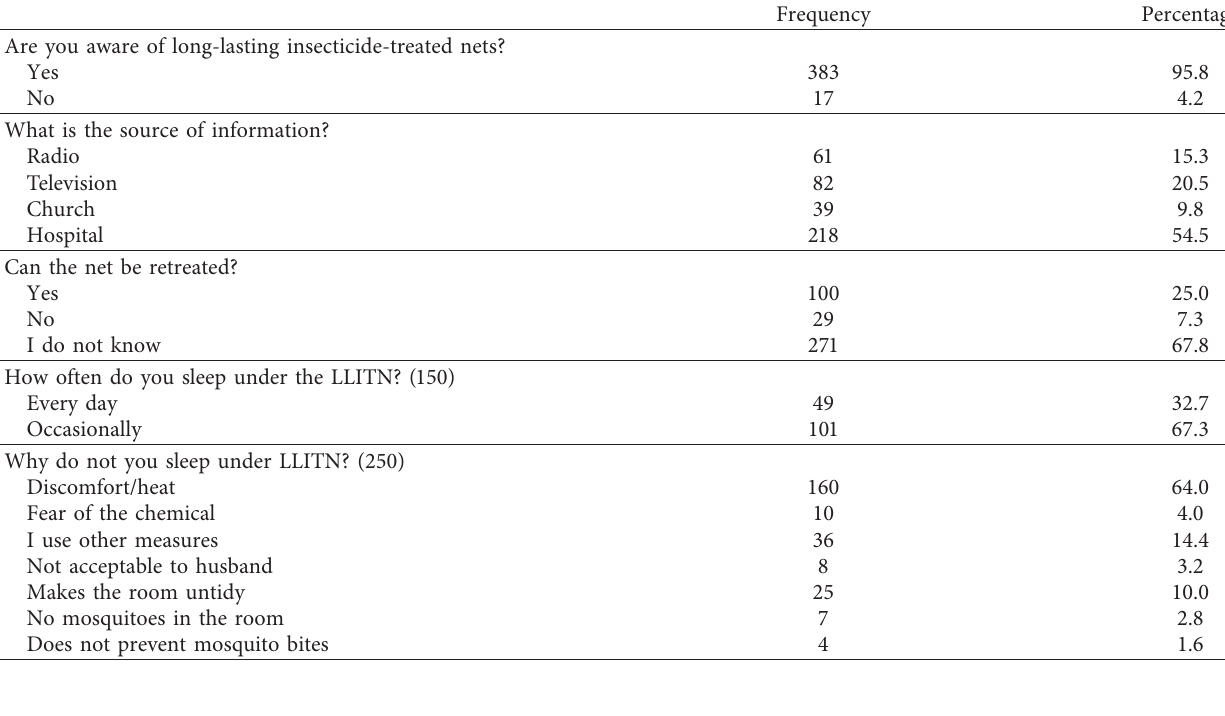
Table 3: Level of utilization of long-lasting insecticide-treated nets.